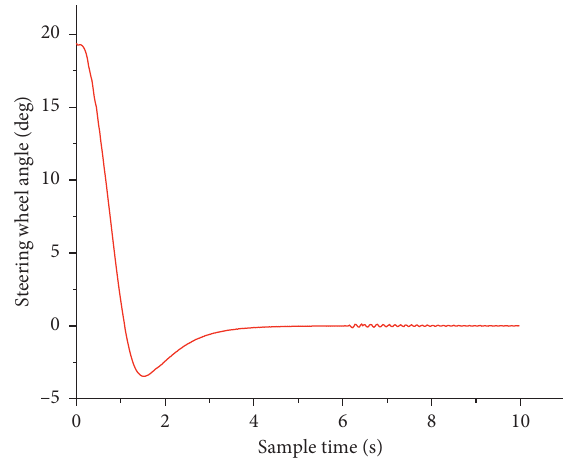
Figure 10: Simulation diagram of straight-line tracking steering angle.